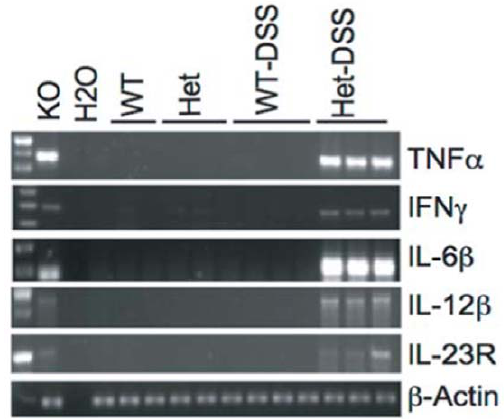
Figure 5. Colonic up-regulation of cytokines mRNA expression. DSS-treated TC-PTP + / 2 (Het-DSS) mice showed up-regulation of TNF a , IFN c , IL-12 b , IL-23R and IL-6. Untreated TC-PTP 2 / 2 (null) mouse colon mRNA was used as a control.